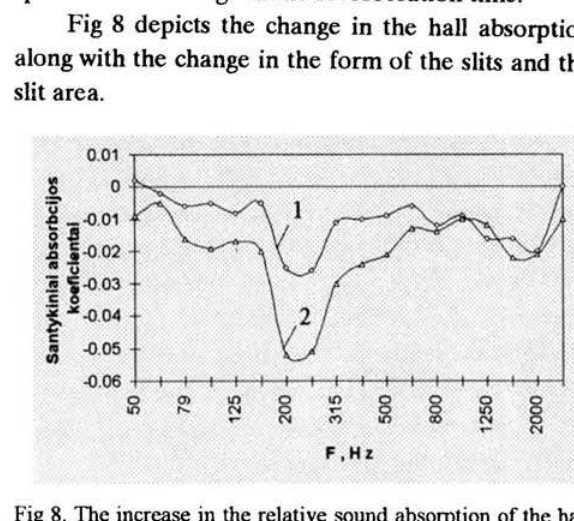
Fig 8. The increase in the relative sound absorption of the hall depending on the form of the slits in the suspended ceiling and the overall slit area. 0 line corresponds to the case without the suspended ceiling. 1 - cross-shaped slits; 2 - rectangularly shaped